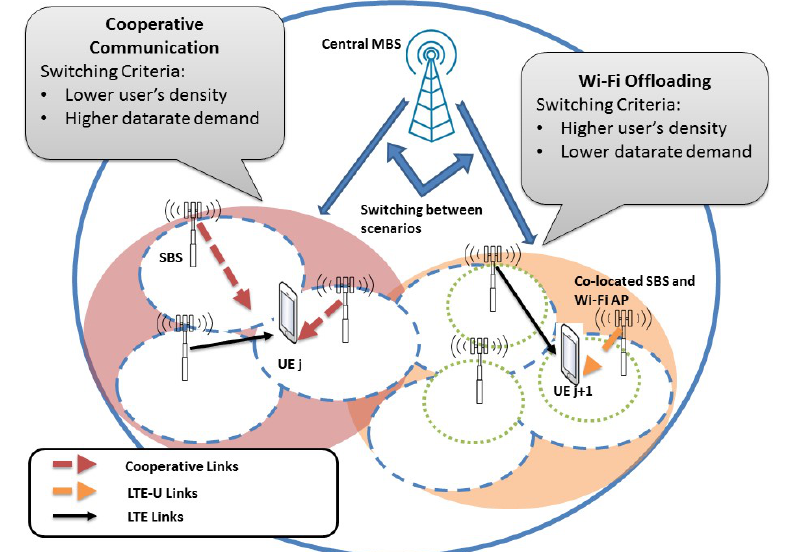
Figure 2. Switching Model Between Cooperation Communication and Wi-Fi